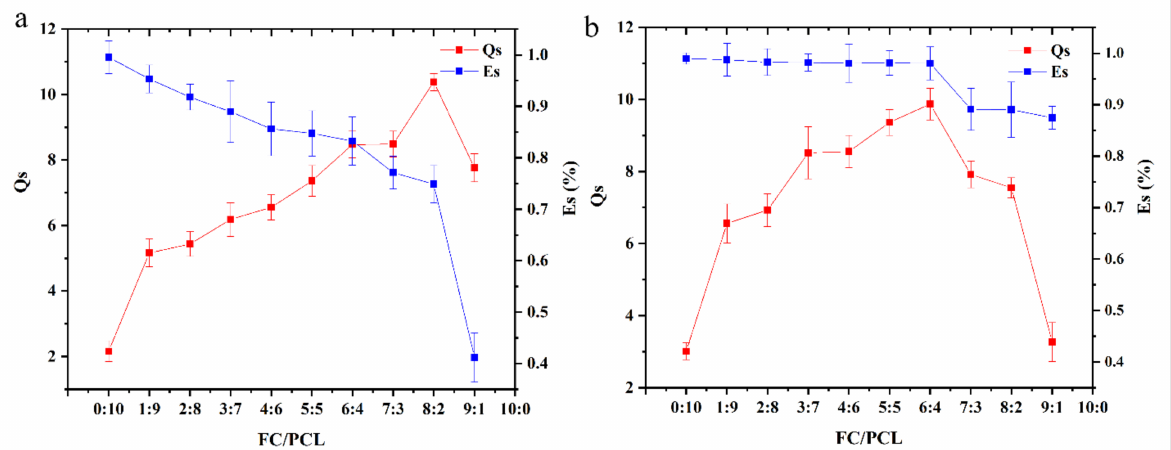
Figure 5. Swelling rate and hydrolysis stability of FC-PCL nanofiber membrane. ( a ) the swelling rate and hydrolysis stability before PEO removal ( b ) the swelling rate and hydrolysis stability after PEO removal.